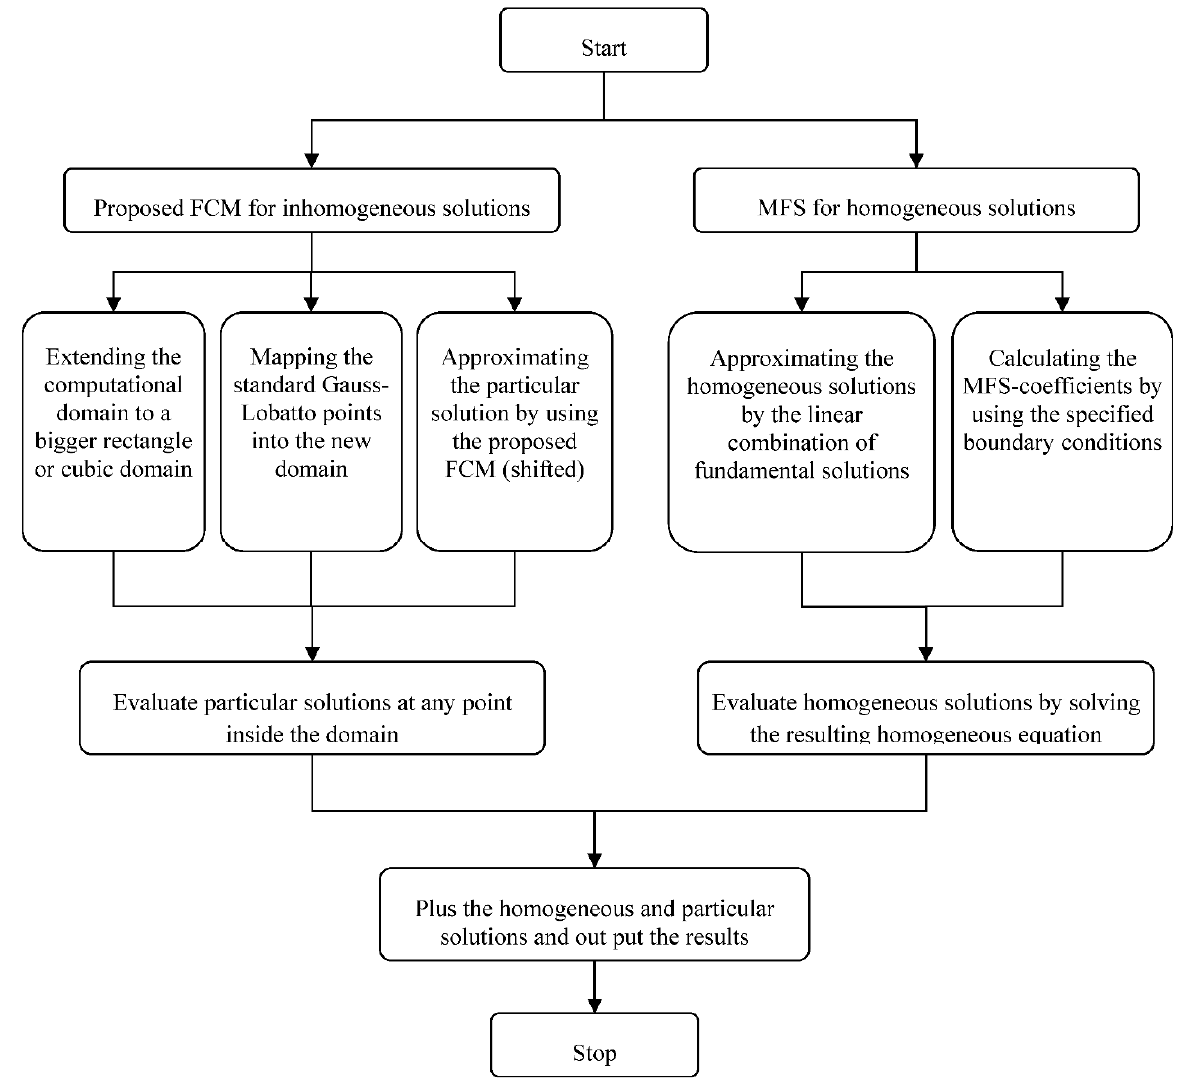
Figure 4. Flowchart for the developed FCM-MFS program.